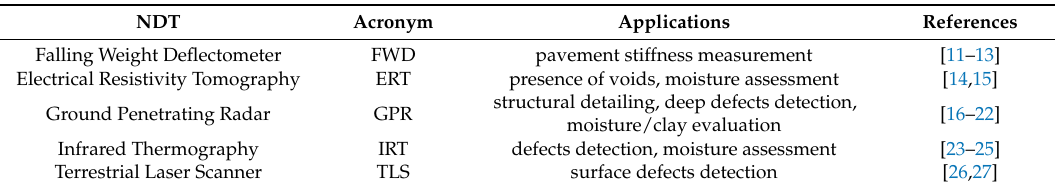
Table 1 lists the most applied NDT methods in road surveying. Table 1. Main NDT methods used in road surveys.